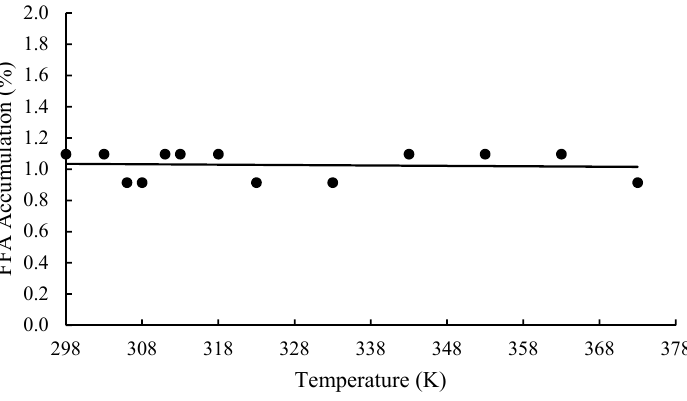
Figure 5. FFA accumulation ( FFA 1 ) in OPF mesocarp after heat treatment for 60 min.